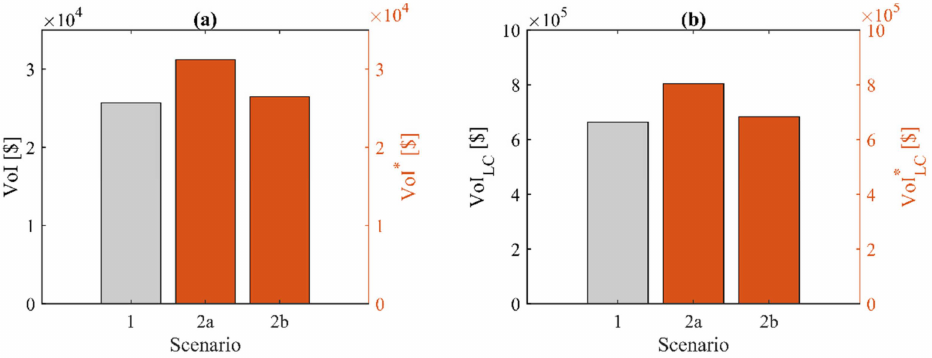
Figure 3. Flood emergency management: ( a ) VoI and ( b ) VoI LC for different decision